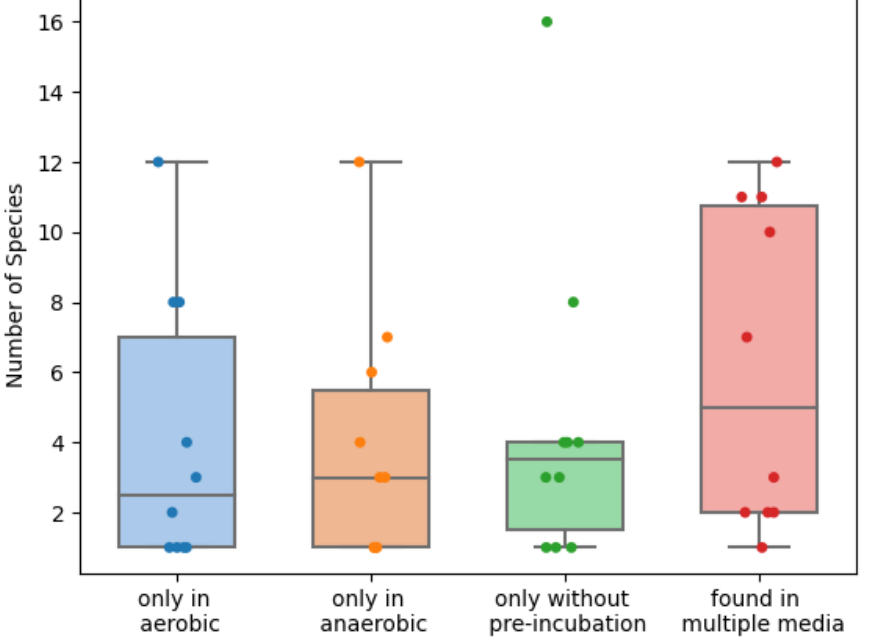
Figure 4. Scattered boxplot for the number of unique species found within each sample per incubation method (blue: aerobic pre-incubation, orange: anaerobic pre incubation, green: no pre-incubation and red: total).